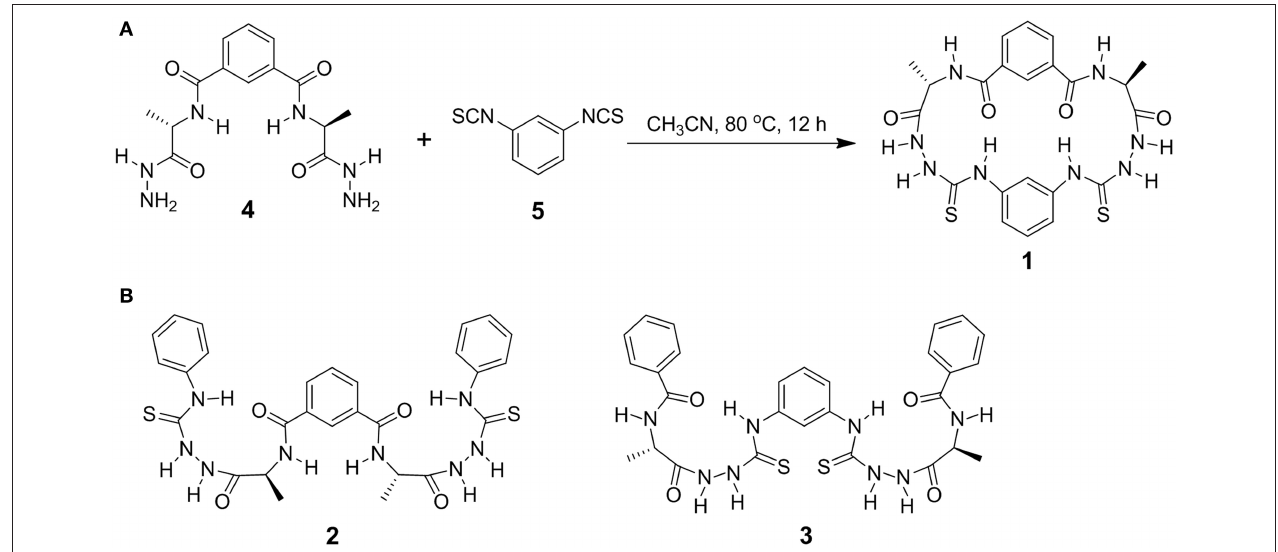
FIGURE 2 | (A) Calculated structure of cyclic azapeptide 1 with two β -turns. Dashed green lines highlight the intramolecular hydrogen bonds of β -turn structures. Method for calculation: B3LYP DFT with the 6-311G** basis set. (B) Influence on –NH protons resonances of 1 in 90:10 (v/v) CD 3 CN/DMSO- d 6 mixtures by temperatures (600 MHz) and the fitted temperature coefficients. [ 1 ] = 1mM. (C) Partial 2D NOESY spectrum of 1 in 90:10 (v/v) CD 3 CN/DMSO- d 6 mixtures. [ 1 ] = 1mM. (D) Absorption and CD spectra of 1 (red line), 2 (blue line), and 3 (black line) in CH 3 CN. [ 1 ] = [ 2 ] = [ 3 ] = 20 µ M.